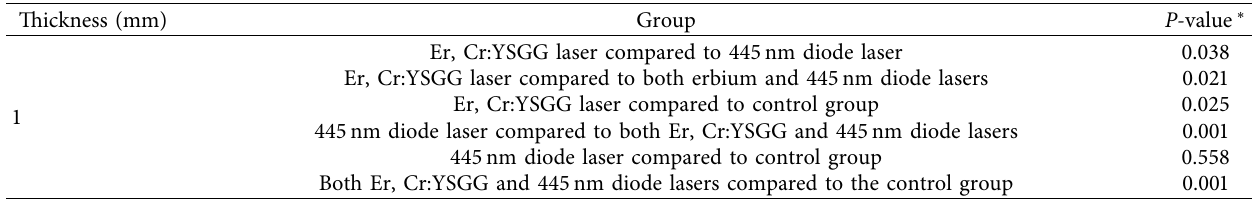
Table 2: Comparison of the number of bacteria in different groups with a thickness of